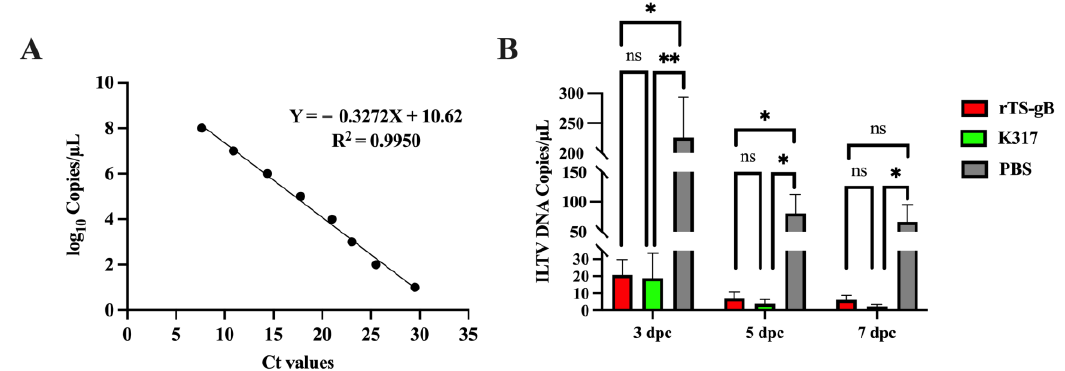
Figure 6. Load of shedding virus in vaccinated birds after virulent ILTV challenge. ( A ) Standard curve for the amplification of ILTV gC plasmid with increasing concentrations. ( B ) The load of shedding virus in tracheal swab samples. The data shown are the values from five swab samples in each group. * p < 0.05; ** p < 0.01. ns, not significant.